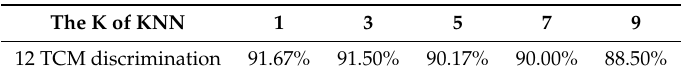
Table 4. Prediction accuracy of KNN with parameter k in offline mode.